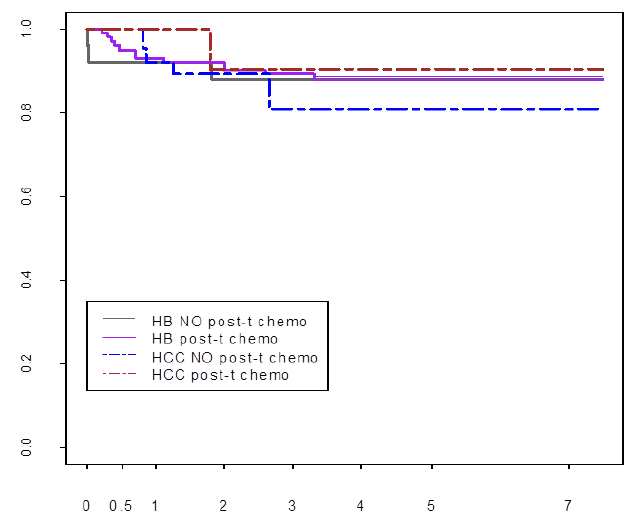
Figure 4. Pre-and post-transplant chemotherapy and survival after LT for HB and HCC. All 149 patients received three cycles of pre-transplant chemotherapy. Ninety six patients also received post-LT